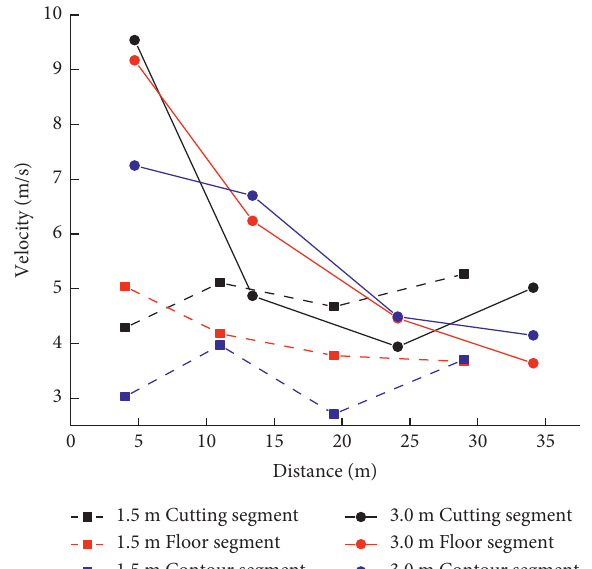
Figure 4: Comparison of the vibration velocity of typical blasting segments with different footage conditions ahead of the corresponding blasting face.